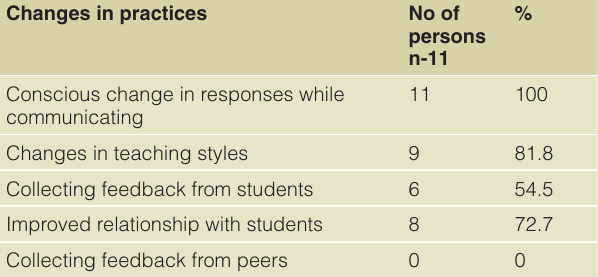
Table 5. Showing the changes in practices of faculty one year after training.